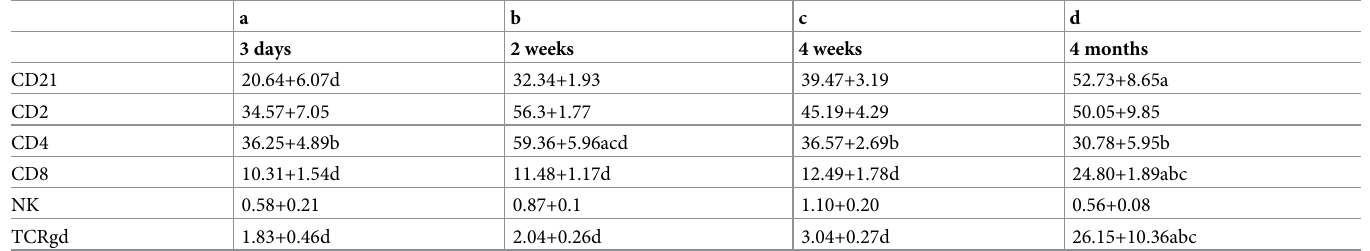
Table 9. Percentages of the studied populations of lymphocytes in lymph